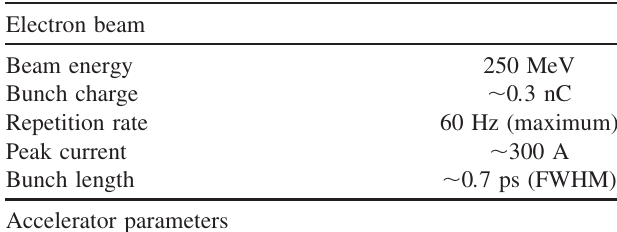
TABLE I. Main accelerator